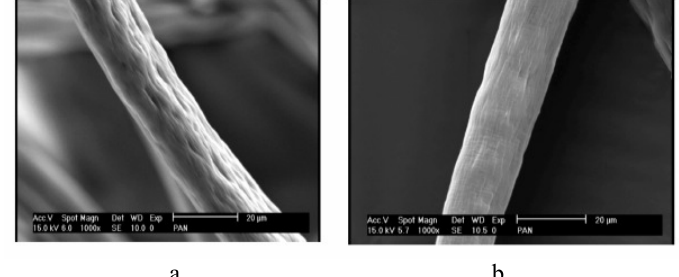
Figure 2 . SEM image of (a) the raw fiber and (b) modified PAN fiber